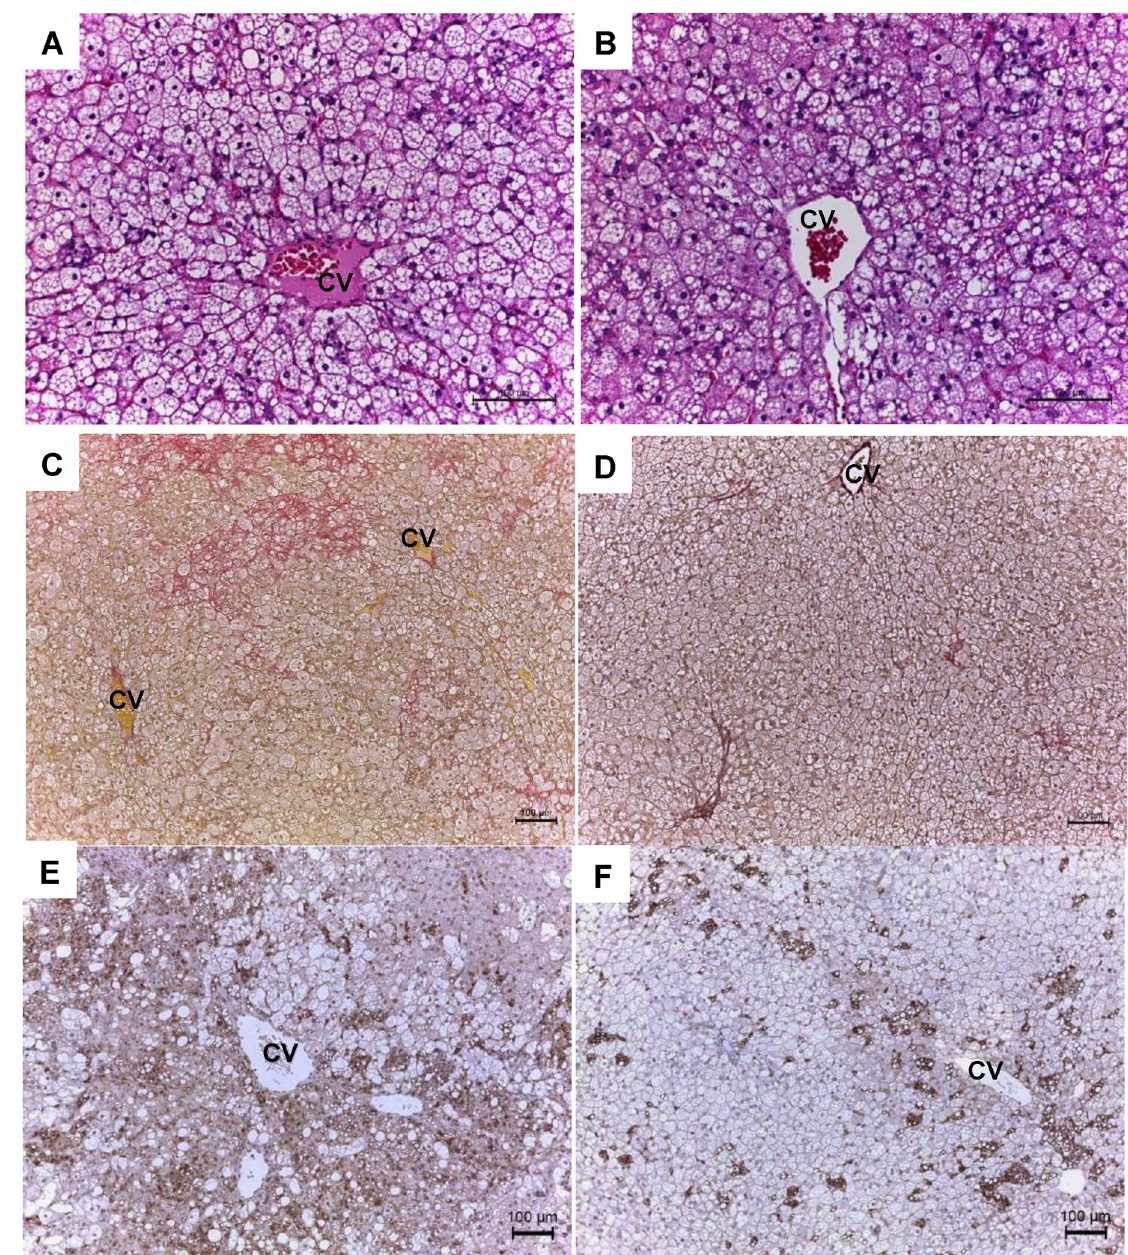
Fig 5. Images of liver sections in the second experiment. Representative images of liver sections subjected to H&E staining (A, B) [magnification: × 200], EVG staining (C, D) [magnification: × 100], and immunostaining with CD68 antibody (E, F) [magnification: × 100]. Liver sections from SHRs fed HFC diet in the absence (A, C, E) or the presence (B, D, F) of hydralazine. Scale bar, 100 μ m. CV, central vein.